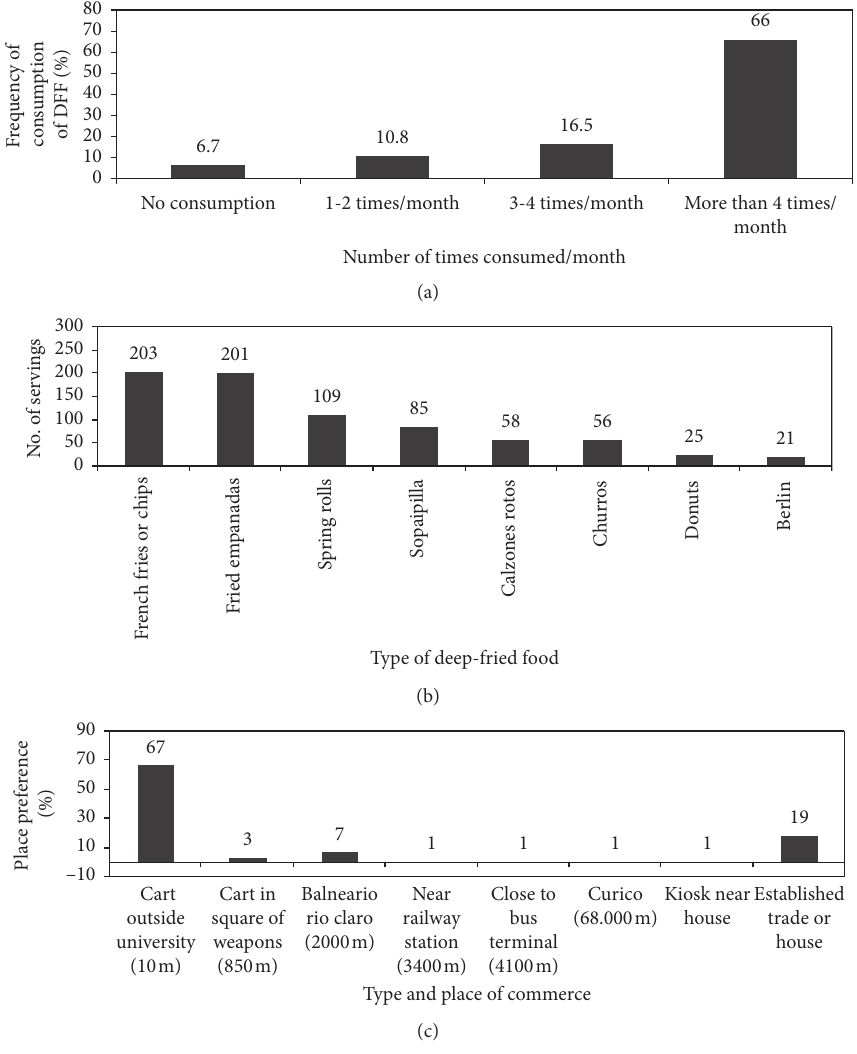
Figure 1: Analysis of the consumption of DFF expended in street commerce by the university students’ population. (a) Frequency of consumption of DFF according to 4 categories: no consumption, 1-2 servings per month, 3-4 servings per month, and more than 4 times per month. (b) Total population preferred consumption of DFF expended in street commerce according to the number of servings/week. (c) Places (itinerant and established) of DFF sale that are preferred by this population and those prepared at home. Table 1: Morbidity history and family history of cardiovascular disease in the examined student population and in the male group and female group.